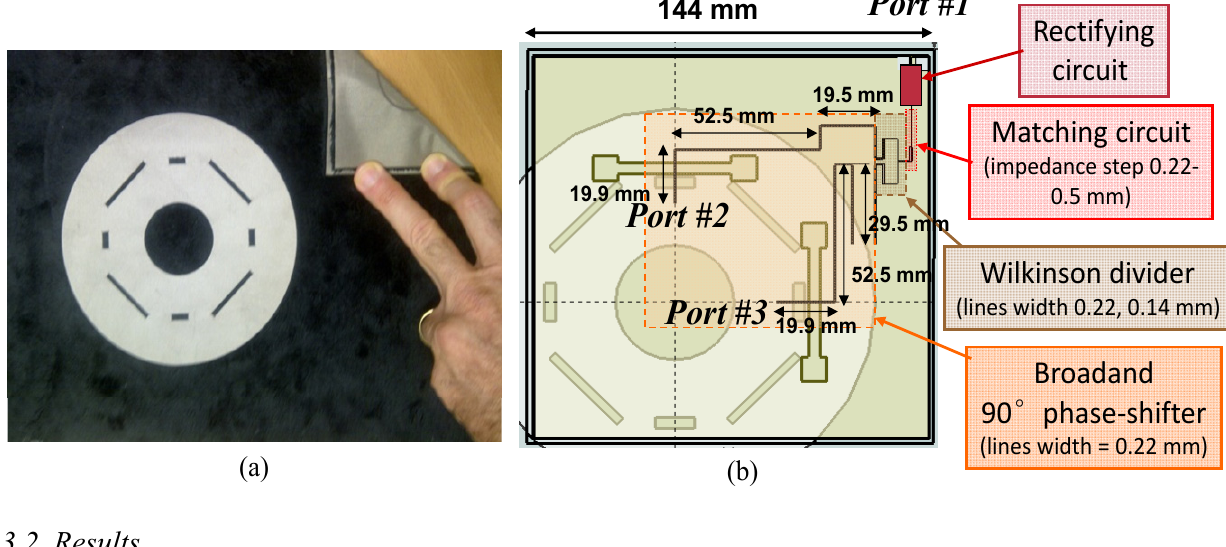
Rectifying circuit Matching circuit (impedance step